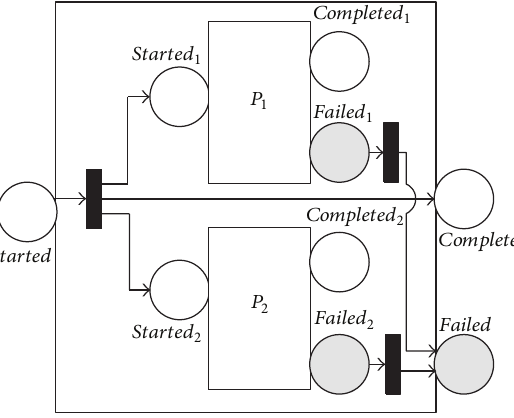
Figure 4: NMSPN model of the split process.